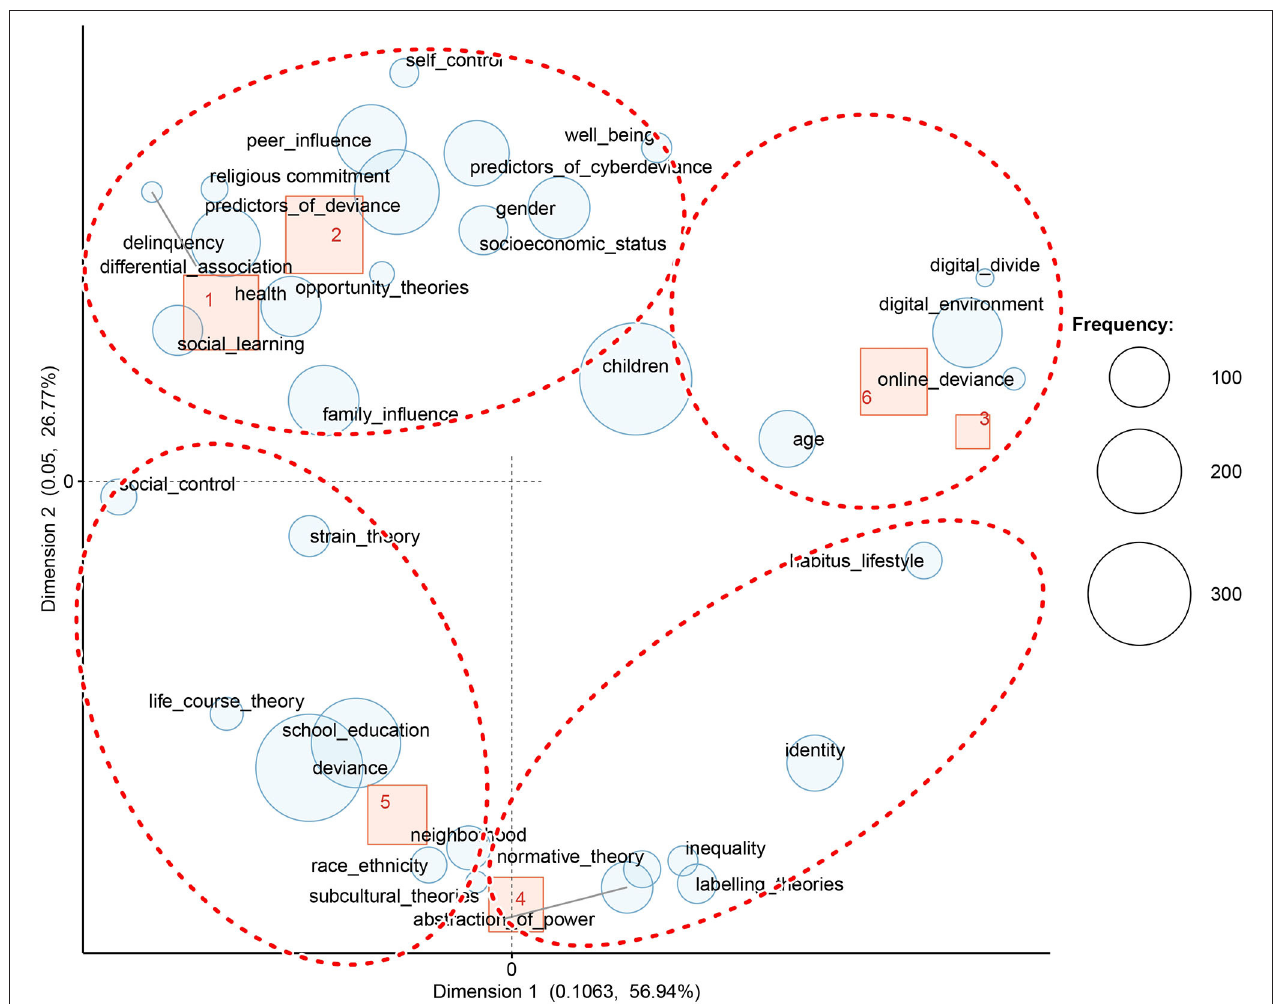
FIGURE 11 | Correspondence analysis of codes as hierarchical clusters abstracts from the whole